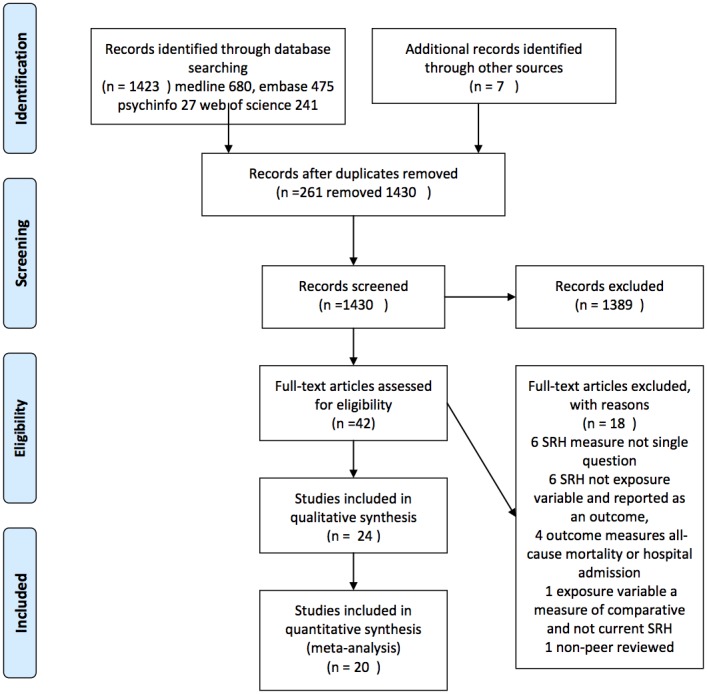
Prisma Flow Diagram.